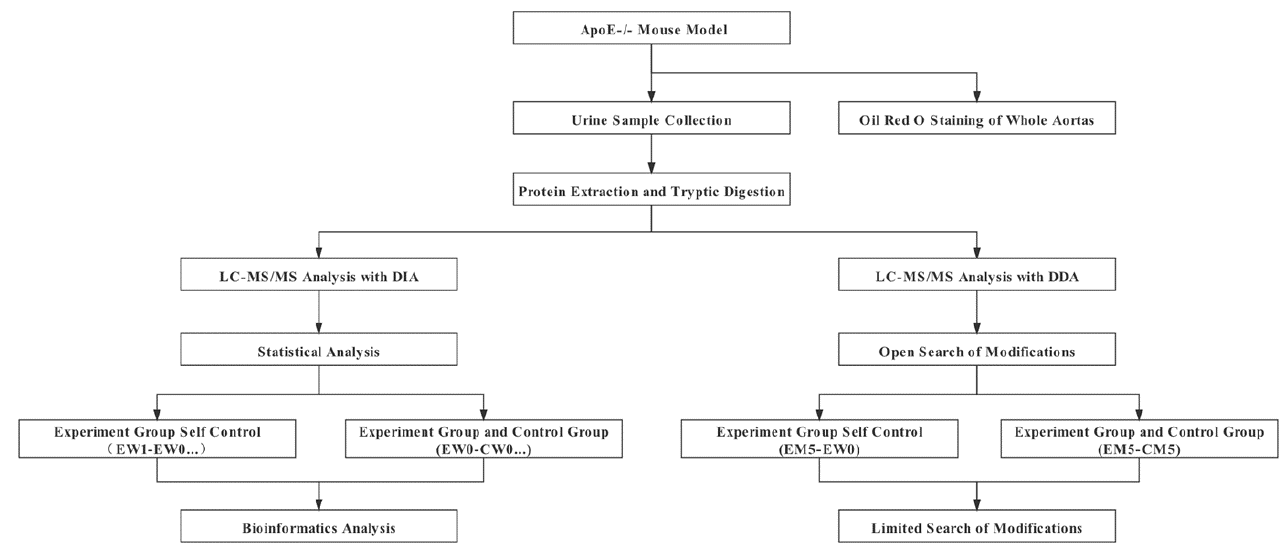
Figure 1. Experimental flow graph.